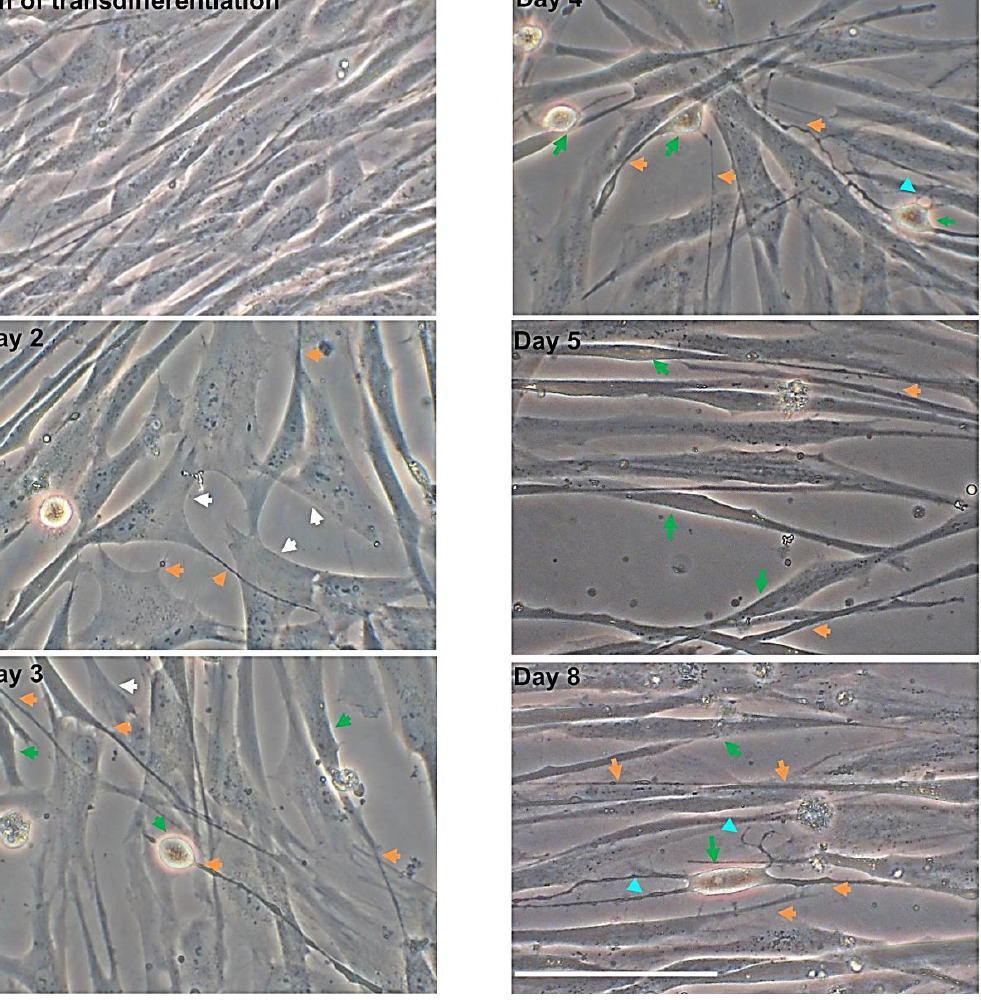
Figure 2. Morphological analysis of CL-hMSCs during transdifferentiation into neuronal-like cells over time. Representative sequence of phase-contrast photomicrographs of hNLCs at 1 h, 2, 3, 4, 5 and 8 days after the transdifferentiation of CL-hMSCs using neurogenic medium. Morphological changes were observed at different stages of hNLCs: the cells adopted a neural-like morphology ranging from spindle shaped (after 1 h transdifferentiation) to spherical with retractile cell bodies (from day 3 to day 5) and long branching processes (day 8, differentiated-stage). Pyramidal cell body and cytoplasm retracted are indicated by white and green arrows respectively, elongated structures are indicated by orange arrows, long extensions with secondary branches are indicated by turquoise headed. Scale bar: 100 µm.